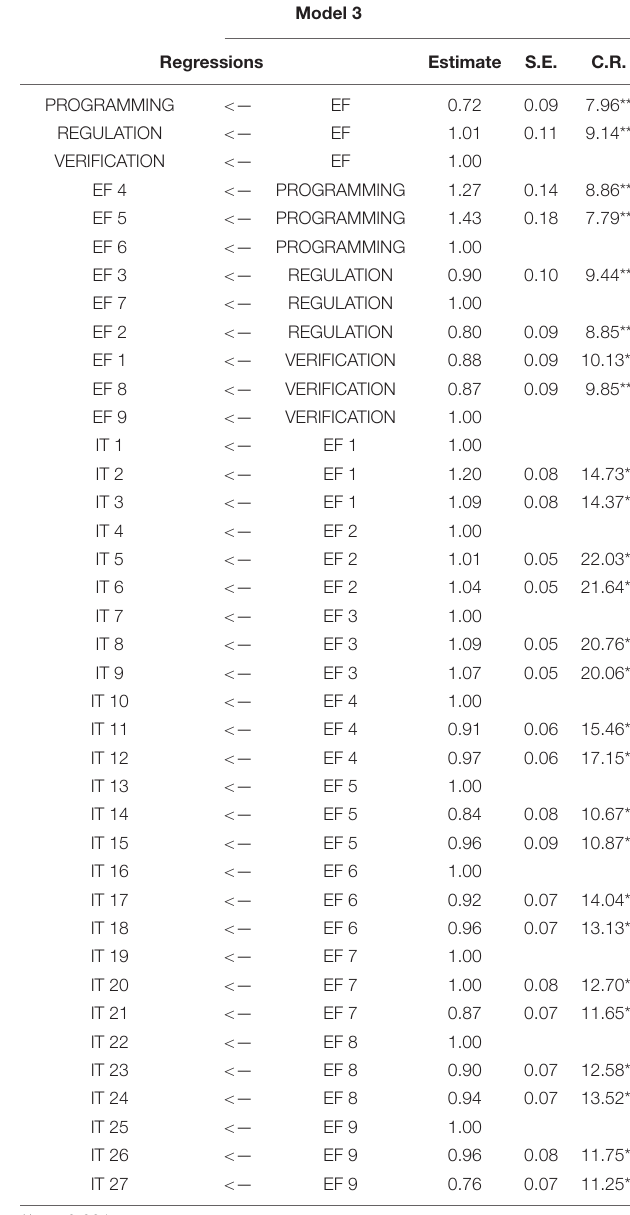
TABLE 7 | Second model’s regression weights. TABLE 8 | Third model’s regression